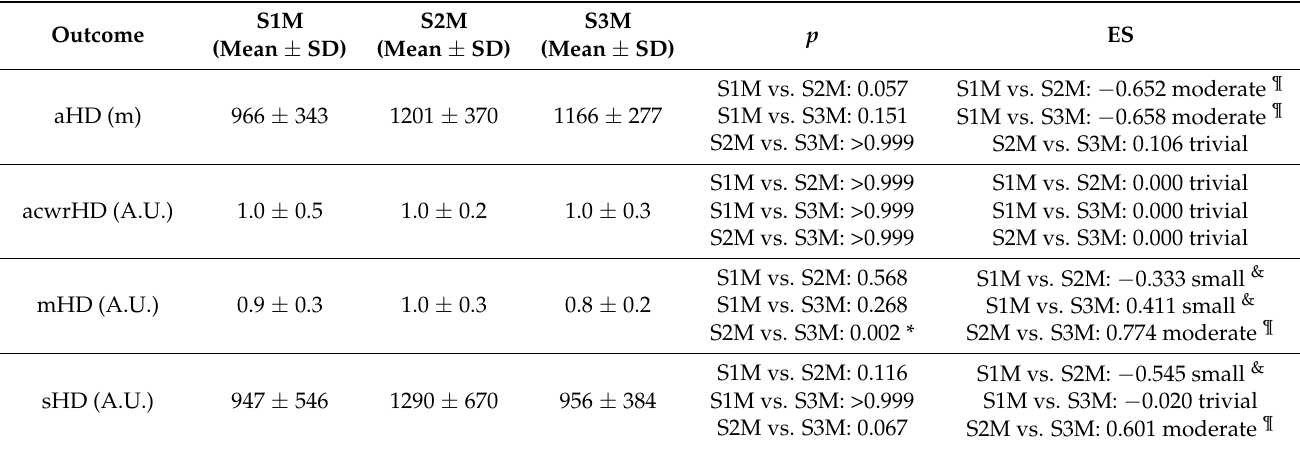
Table 4. Descriptive and inferential statistics (mean ± SD) of high decelerations workload indices in different levels of participation in